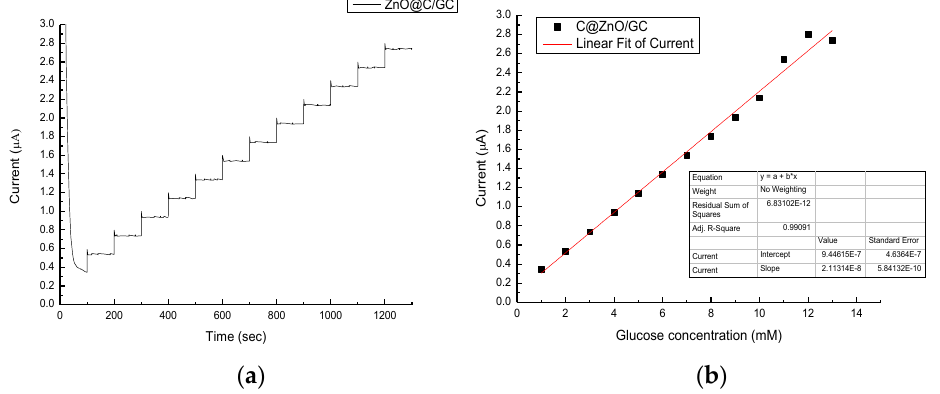
Figure 10. ( a ) The current vs. time curve of ZnO@C/GC electrode in 1 M NaOH (aq) and glucose (aq) solution, where the glucose (aq) was added 1 mM per 100 s. ( b ) The corresponding linear fitting of the stabilized current and glucose concentration from (a).